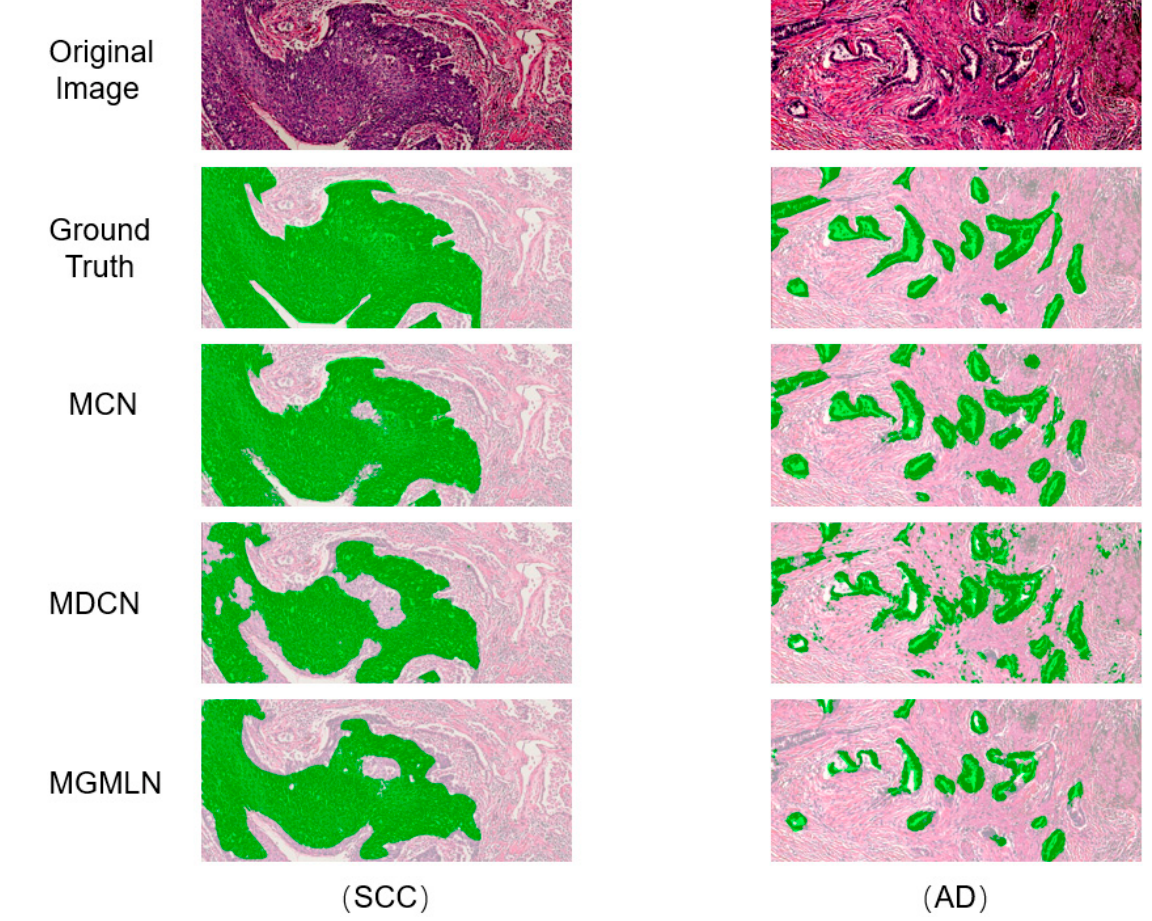
Figure 4. Comparison of the segmentation results for SCC and AD obtained with our method (MCN) and other two methods (MDCN and MGMLN).